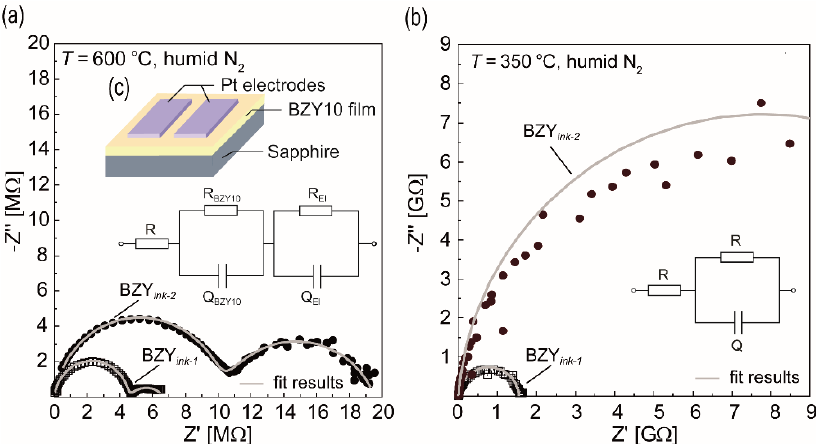
Figure 13. Impedance spectra of the two ink-jet printed BZY10 films BZY ink- 1 (molecular based) and BZY ink- 2 (nanoparticle based) measured at different temperatures by in-plane mode. Shown are also the results of the fitted semicircles (grey lines), which have been obtained according to the schematically depicted equivalent circuits. ( a ) 600 °C in humidified nitrogen. ( b ) 350 °C in humidified nitrogen. The inset ( c ) shows the sample design used for the in-plane measurement of the impedance.